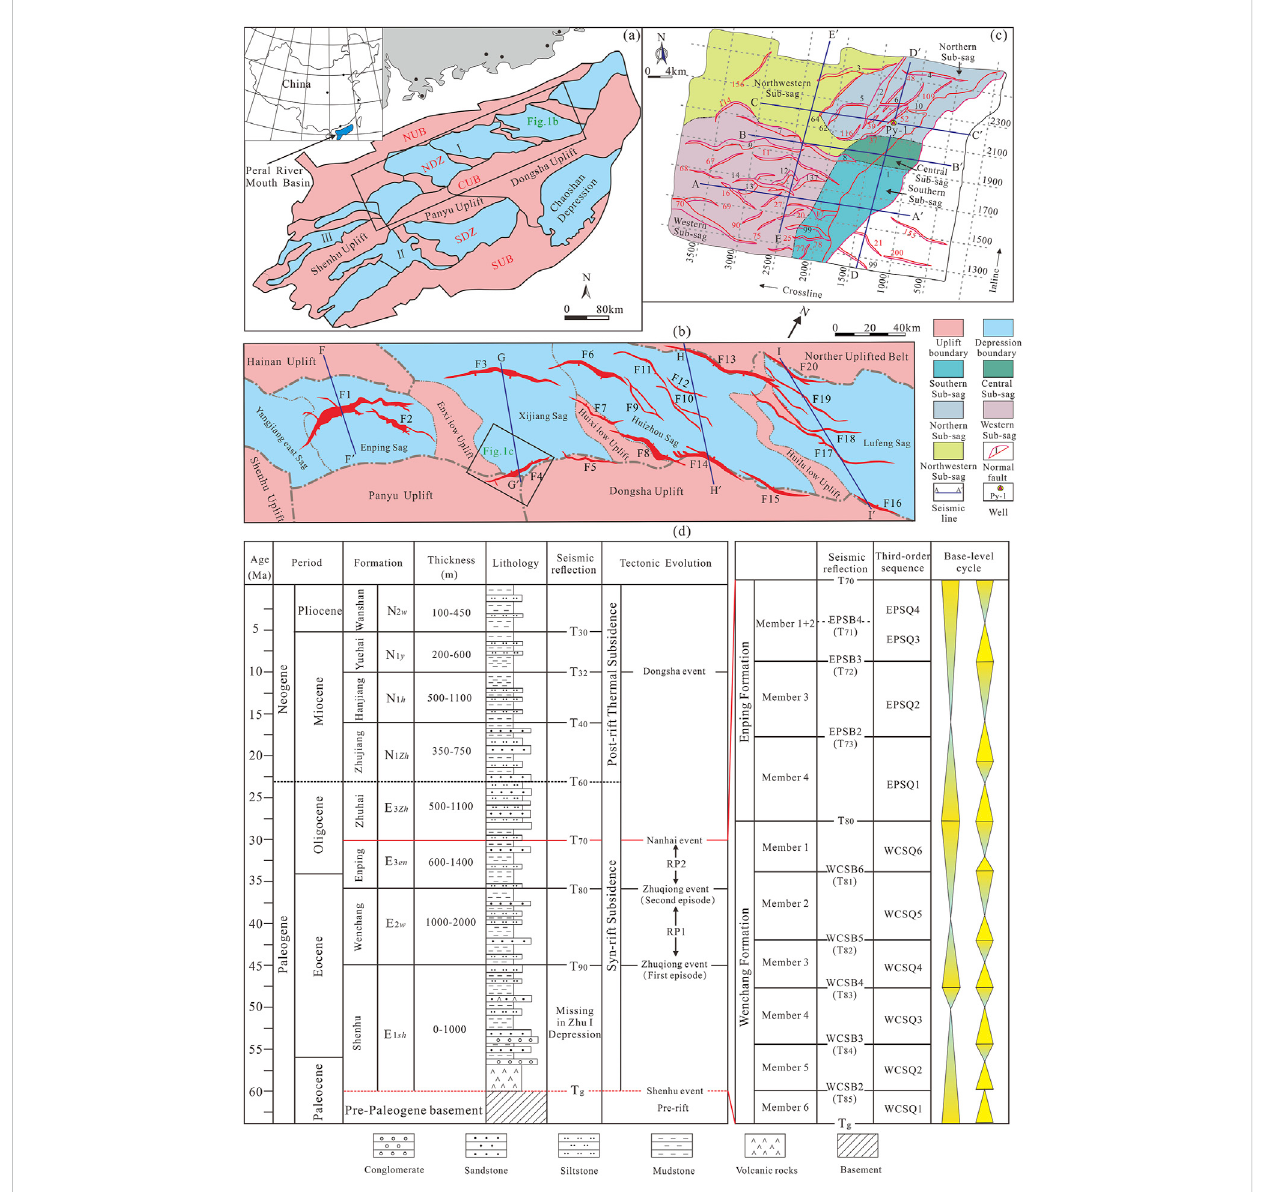
FIGURE 1 (A) LocationandstructuralunitsofthePearlRiverMouthBasin,SouthChinaSea,NUB-NorthernUpliftBelt,NDZ-NorthernDepressionZone,CUB- CentralUpliftBelt,SDZ-SouthernDepressionZone,SUB-SouthernUpliftBelt, Ⅰ -Zhu Ⅰ Depression, Ⅱ -Zhu Ⅱ Depression, Ⅲ -Zhu Ⅲ Depression(Liuetal., 2019); (B) The structural units and major faults of the top of the basement in the Zhu Ⅰ Depression (Hu, 2019); (C) The structural units and major faults of the Panyu 4 Sag; (D) Tectonostratigraphic evolution of the Pearl River Mouth Basin (modi fi ed after Chen and Zhang, 1991; Zhang et al., 2003; Zhu et al.,